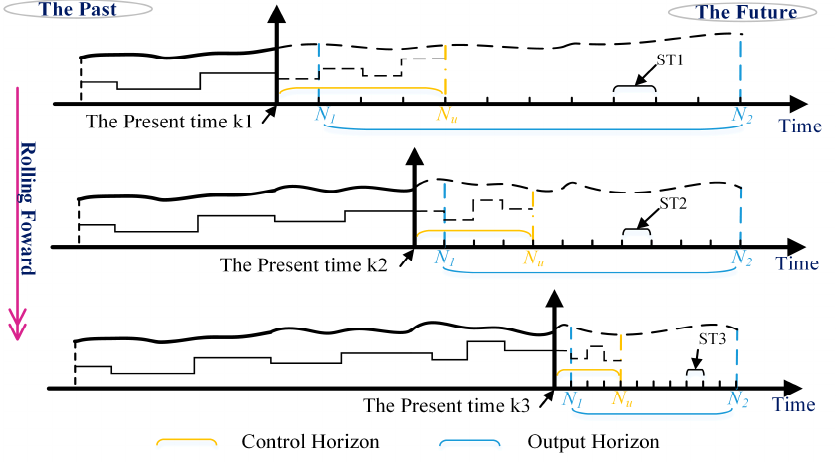
Figure 5. The schematic of variable step size generalized predictive control